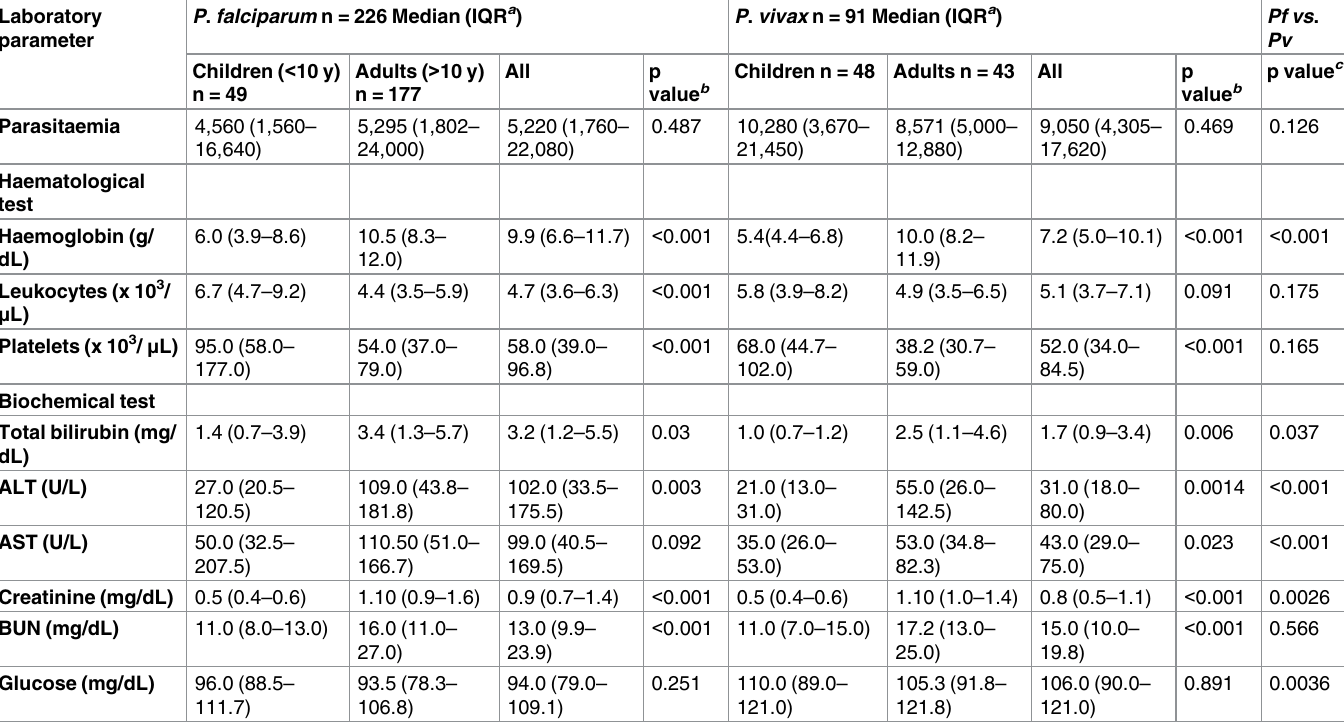
Table 4. Laboratory parameters in children and adults with complicated malaria according to Plasmodium